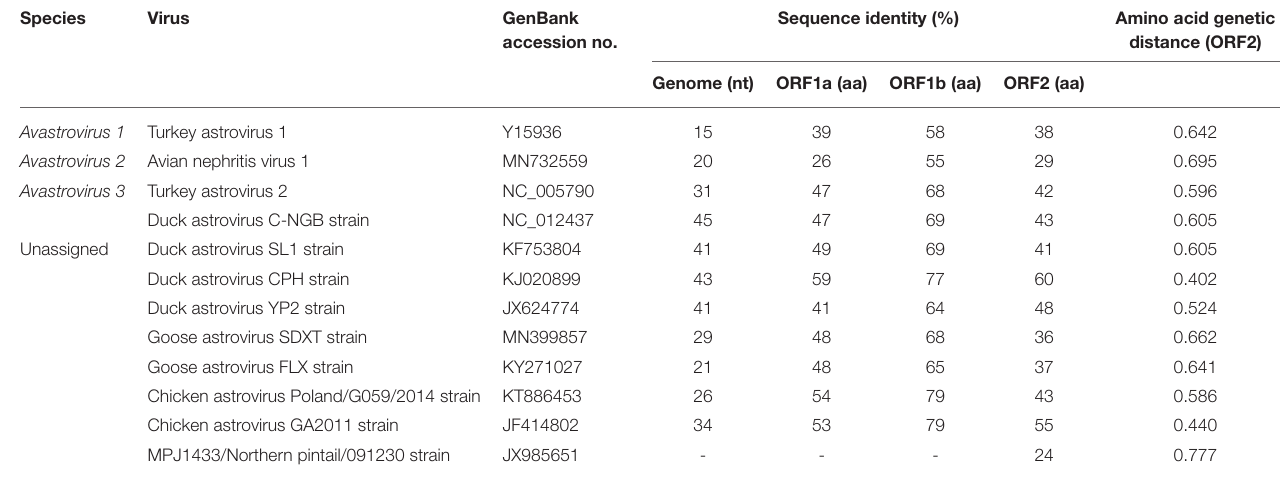
TABLE 1 | Comparison of complete genome sequences and amino acid sequences of the three ORFs of DAstV-5 JM strain with other representative strains of avastroviruses. Species Virus GenBank accession